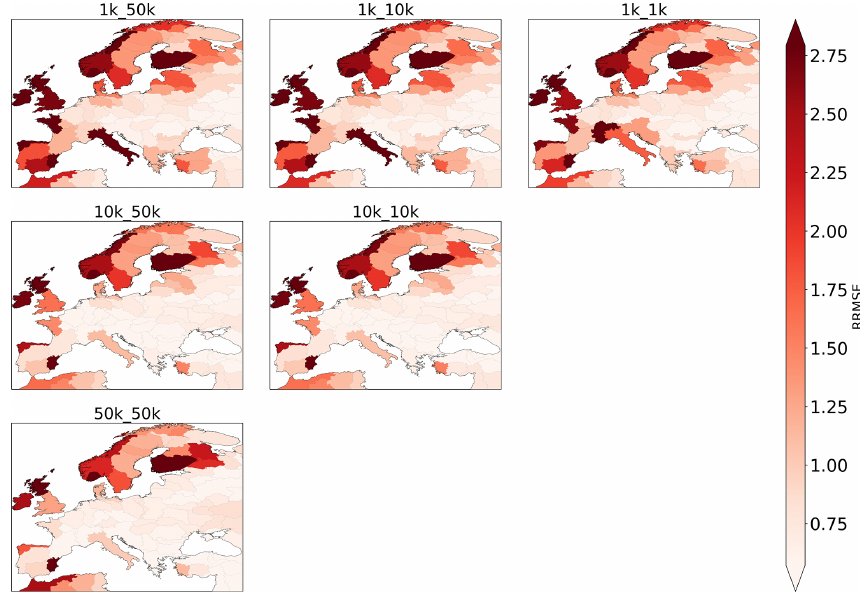
Figure 8. RRMSE values computed per water province based on simulated total water storage anomalies and terrestrial water storage anomalies from